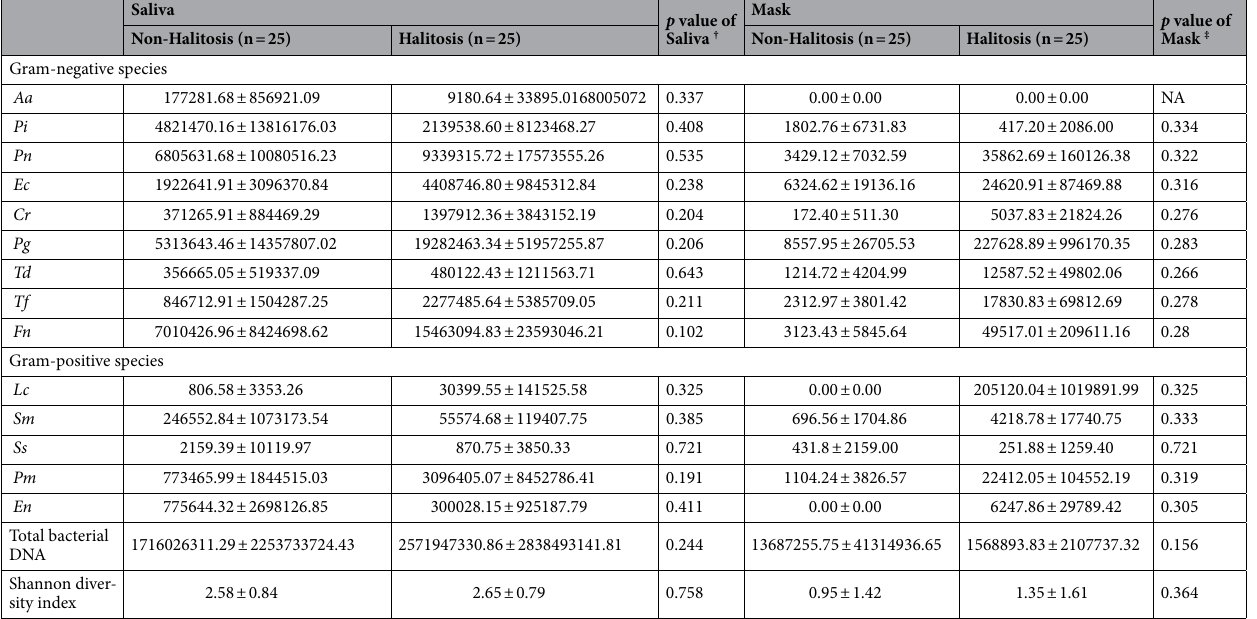
Table 2. Composition and diversity of bacteria on the inner surface of the mask and unstimulated whole saliva. Results were obtained via Mann–Whitney U test. p value was considered as significant when p value < 0.05. †Comparison of the bacteria in saliva between non-halitosis and halitosis groups. ǂ Comparison of the bacteria of the inner surface of the mask between non-halitosis and halitosis groups. Aa: